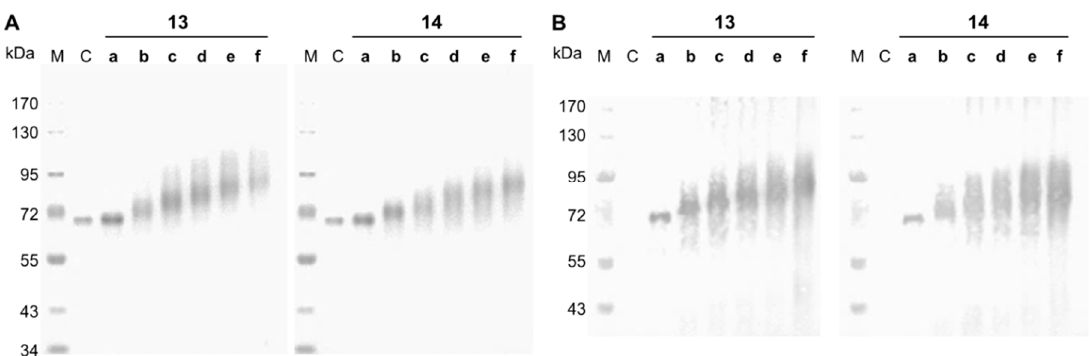
Figure 1. SDS-PAGE and streptavidin blot analysis of neo-glycoproteins. The BSA-based neo-glycoproteins were analyzed by SDS-PAGE with Coomassie staining ( A ) and by a streptavidin blot ( B ); M, Marker; C, control (BSA); 13a – f , 6-biotin LacNAc-LacNAc conjugated BSA; 14a – f